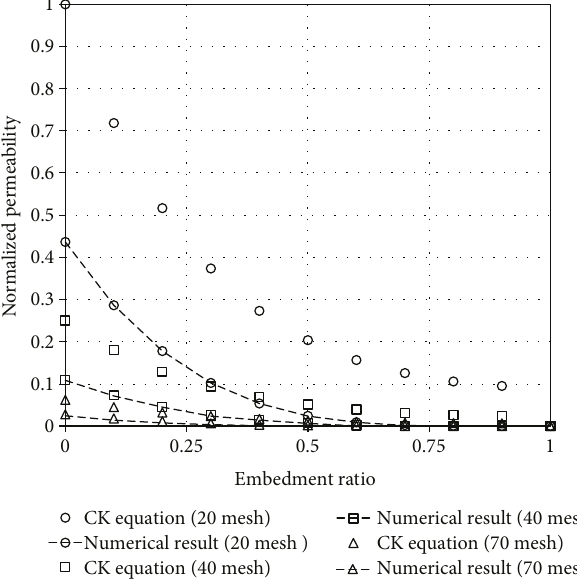
Figure 13: E ff ect of grain sizes and embedment ratio on